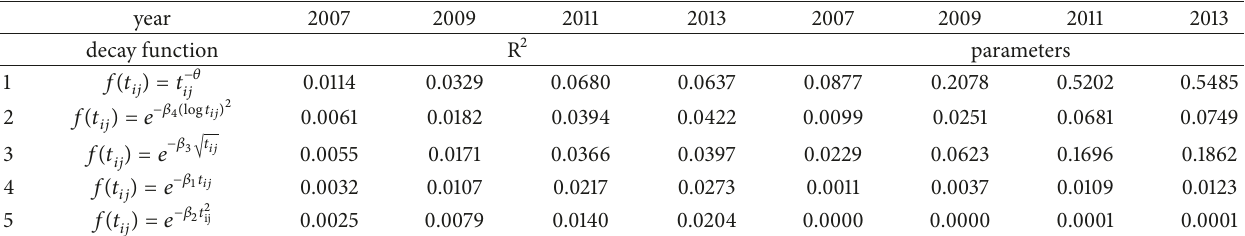
Table 3: Fitting degree and parameter values of decay function from 2007 to 2013.